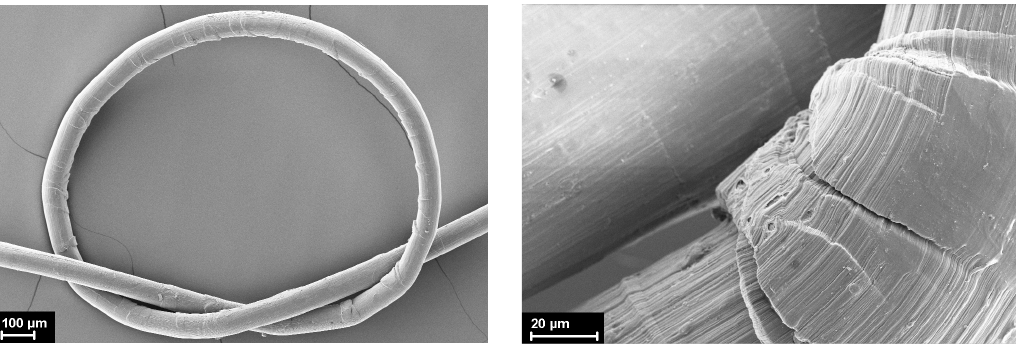
Figure 7. Scanning electron micrographs of the knot of the oriented HDPE-based composite fiber.